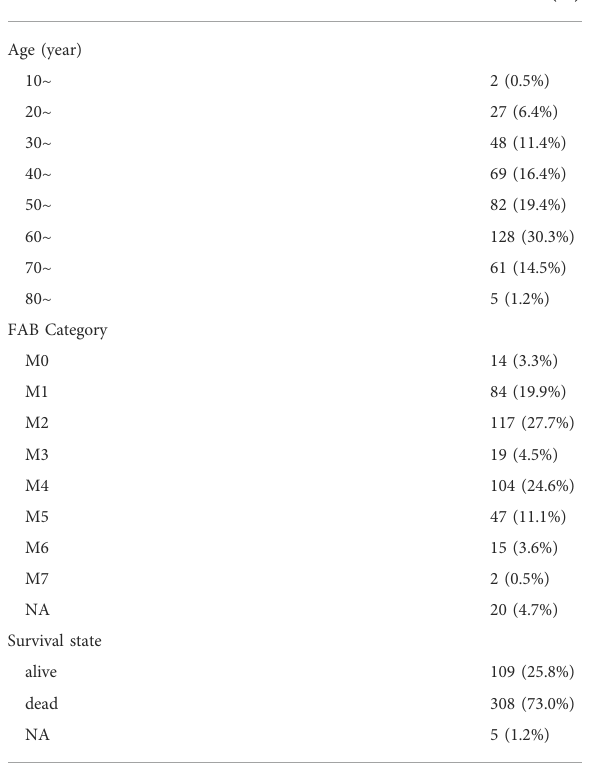
TABLE 2 Baseline characteristics for 422 patients with AML in the GEO database ( n = 422).